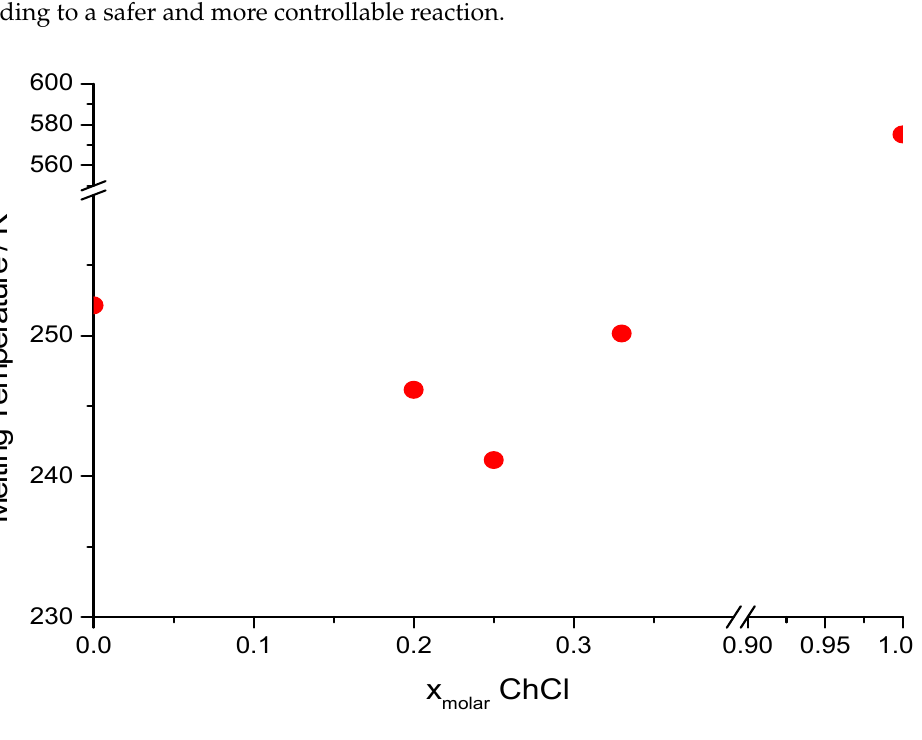
Figure 2. Experimental phase-diagram of AGly and ChCl mixtures built up by using the T m values of the precursor available in the literature (confirmed in our labs) and the experimental T m values of the mixtures as an average of the values obtained from the different approaches reported in the experimental section. The error bar is lower than 2 K for all the mixtures.